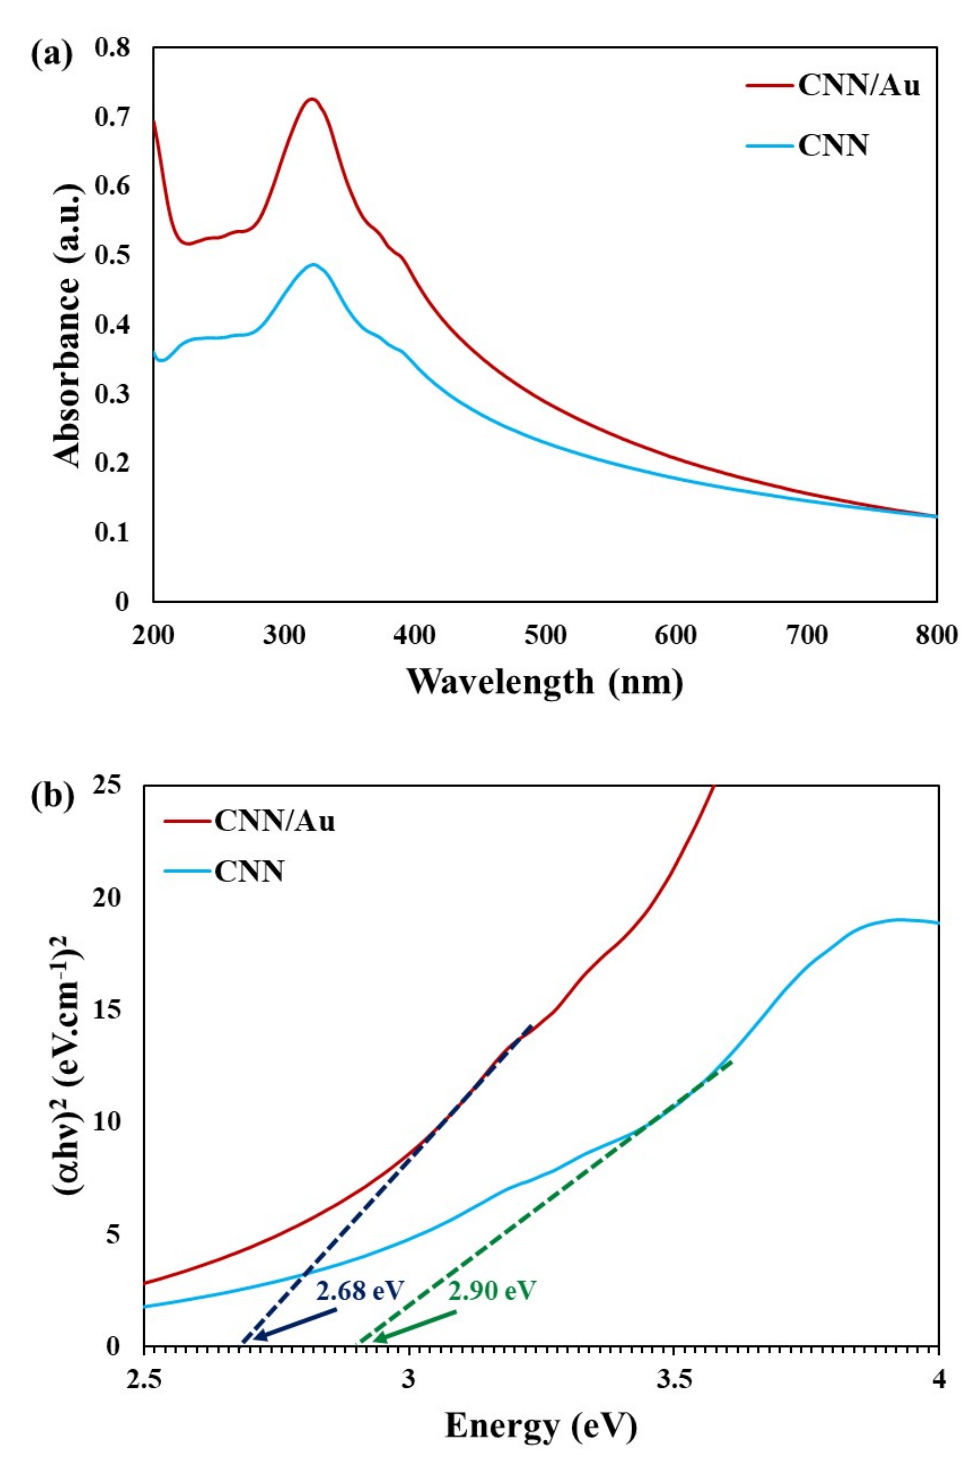
Figure 7. ( a ) UV-Vis spectra of CNN and CNN/Au compounds, ( b ) Tauc plot of inset UV-Vis spectra for CNN and CNN/Au.